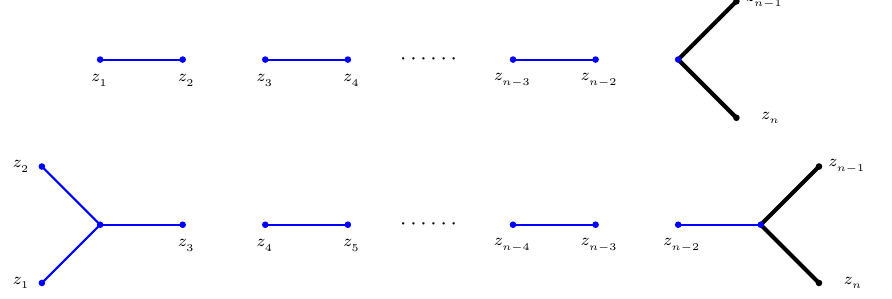
Figure 13 . Vacuum blocks with even n . The upper diagram corresponds to the disconnected Figure 9 . Vacuum blocks with even n . Steiner tree (a) on (cid:12)gure